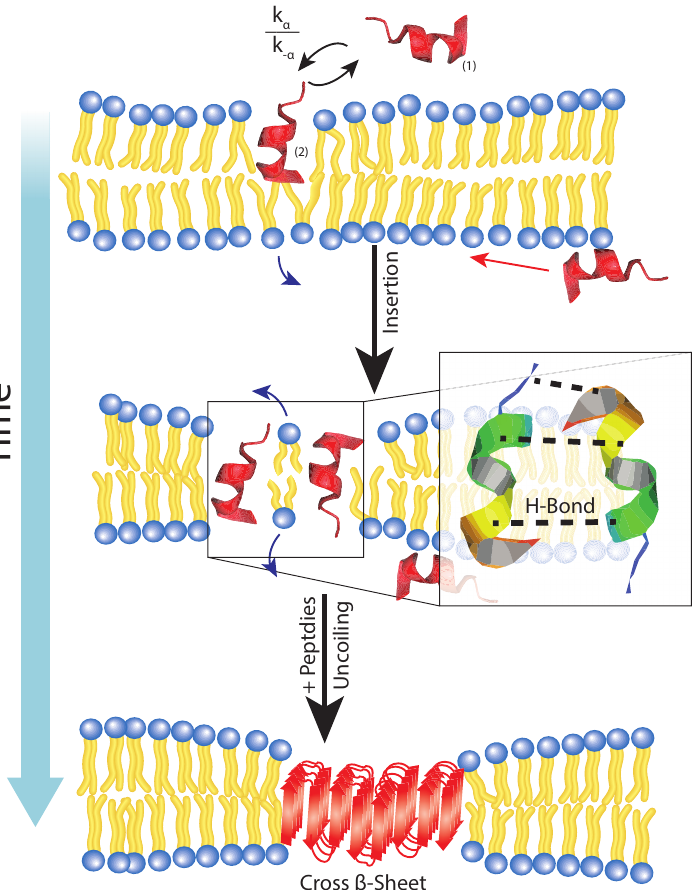
Figure 7. A β 25 − 35 coexists in an external and inserted phase in which there is a certain free energy barrier which inhibits full insertion. For this reason, there is a rate of insertion and expulsion within the membrane. After the insertion, H-bonding between enighbouring Glu and Arg residues coordinate lateral attraction and promote the formation of a cross- β sheet through the U-turn N-terminus residues external to the